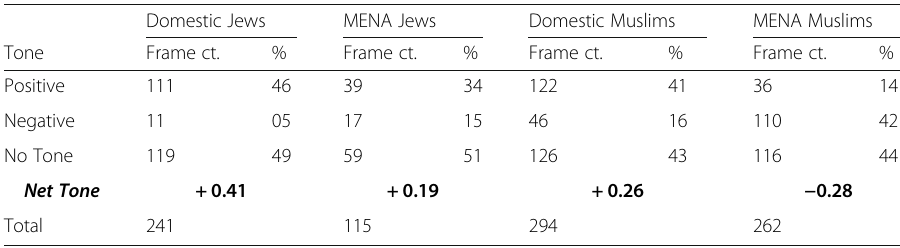
Table 4 Aggregate Net Tone – Domestic &